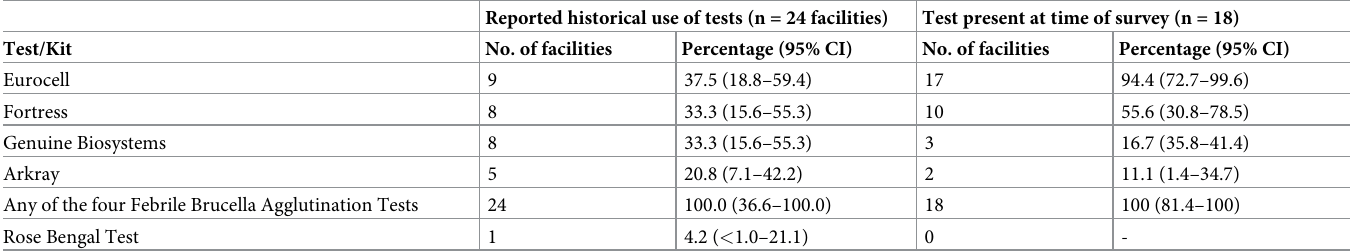
Table 4. Data on facility level use of brucellosis tests for past reporting (n = 24 facilities) and test kits present at time of survey (n = 18